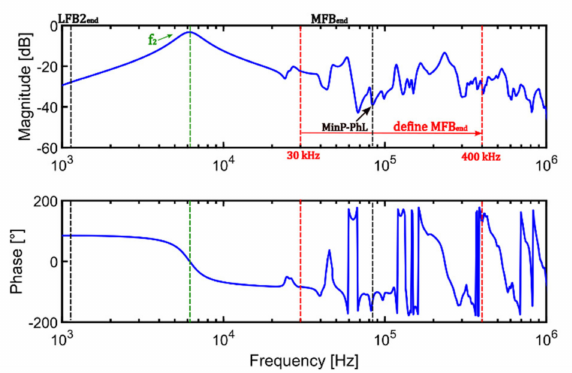
Figure 13. An example of class 3 FRA plot for identification of the MFB end .